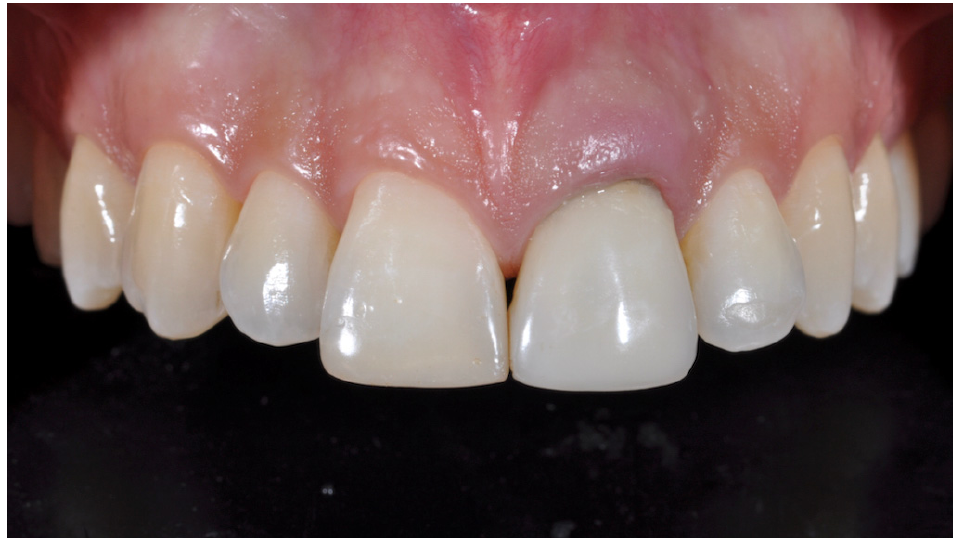
Figure 3. Preclinical intraoral picture, after the second trauma, frontal